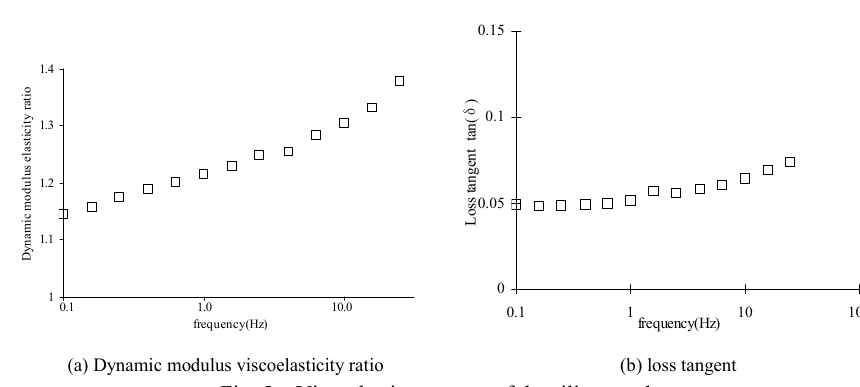
Fig. 5 Viscoelastic property of the silicone